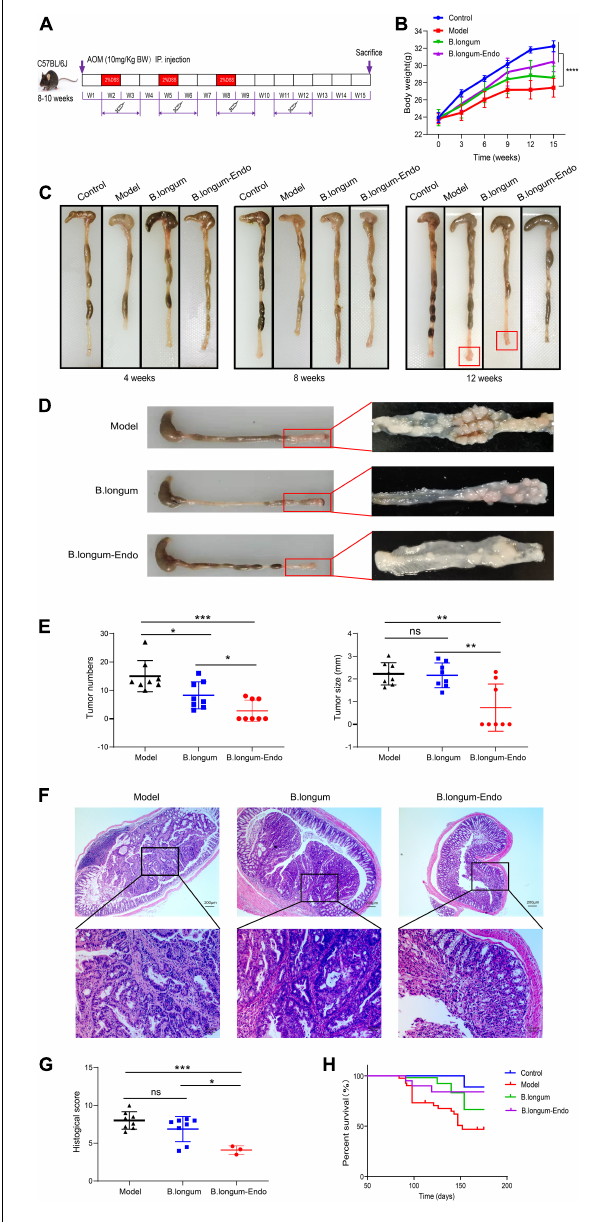
FIGURE 4 | B. longum-Endo inhibits AOM/DSS-induced colon tumorigenesis. (A) Schematic representation of AOM/DSS-induced colitis-associated colon cancer mouse model. (B) Body weight. (C) Representative photographs showing colon tissue at different stages. (D) The formation of solid tumors in the distal colon was observed by naked eye. (E) Tumor number and tumor size. (F,G) Representative hematoxylin and eosin-stained images and histopathological scores. (H) The 25-week survival curve after three 2% DSS cycles. Data are expressed as mean ± SD of three independent experiments ( n = 6–8). * P < 0.05, ** P < 0.01, *** P < 0.001, **** P < 0.0001, and ns: not